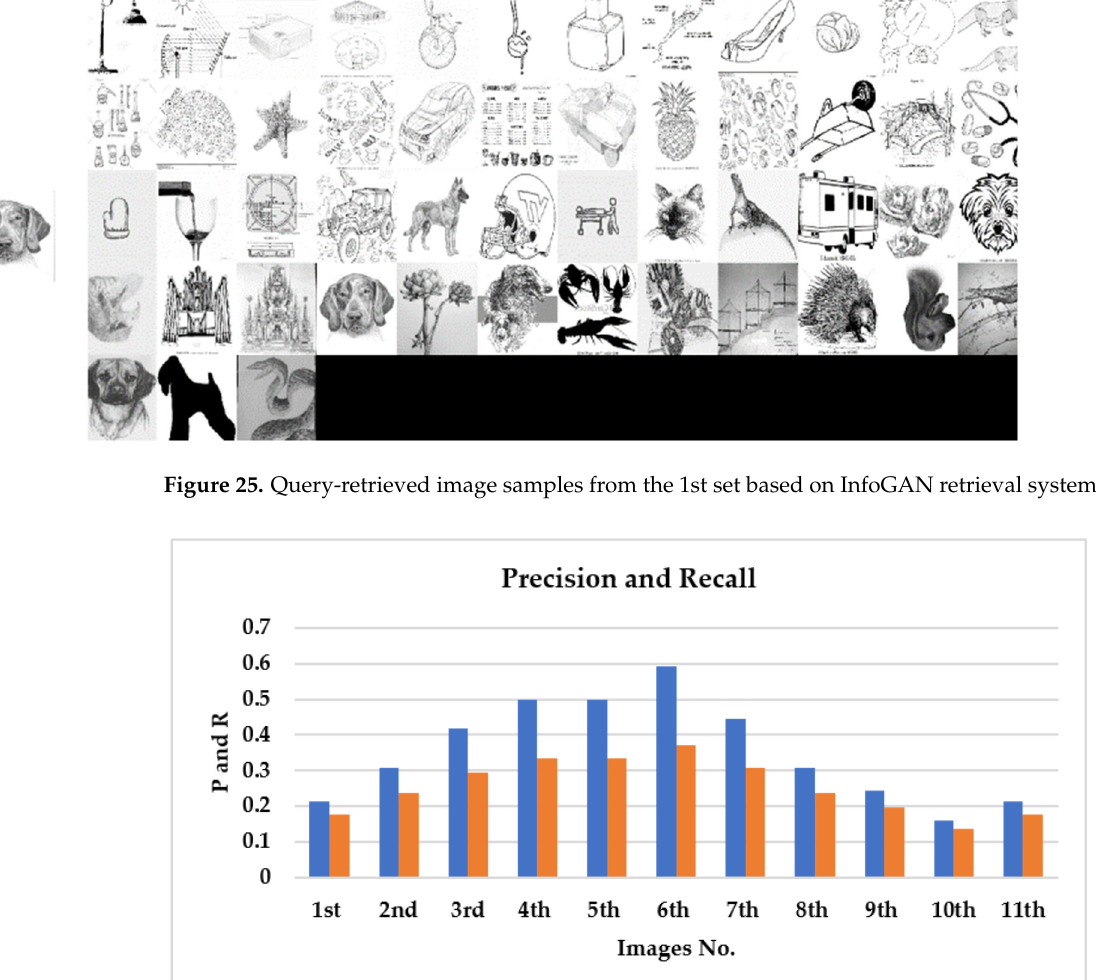
Figure 26. Precision and recall computed for ImageNet-Sketch dataset based on InfoGAN.